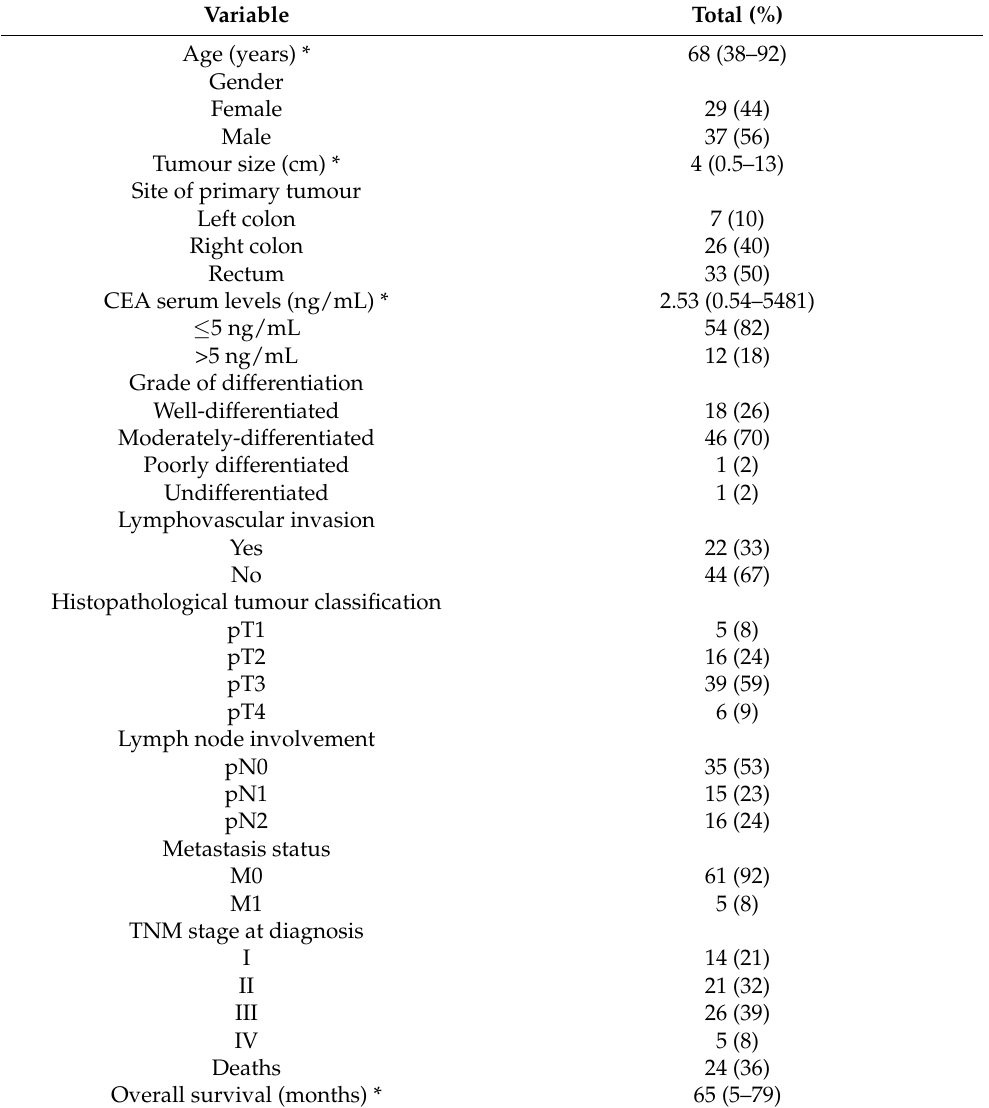
Table 1. Clinical and biological characteristics of sCRC patients (n = 66) at